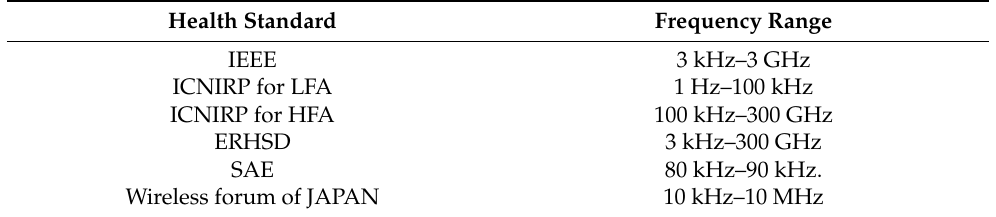
Table 3. Frequency ranges for standards. Health Standard Frequency Range IEEE 3 kHz–3